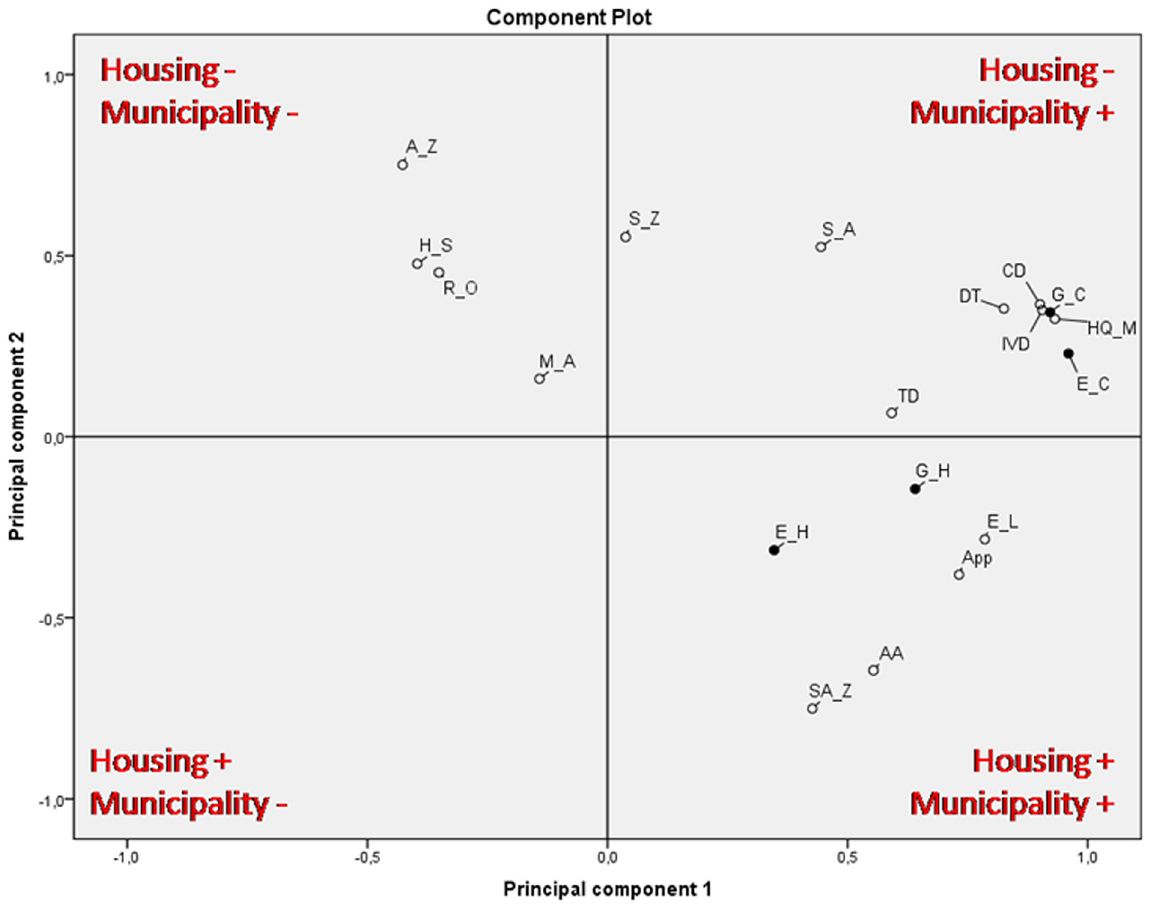
fig. 6. PCA of all the variables used to cluster municipalities according to their population characteristics, dwelling typology, population distribution, climate zone, and appliance